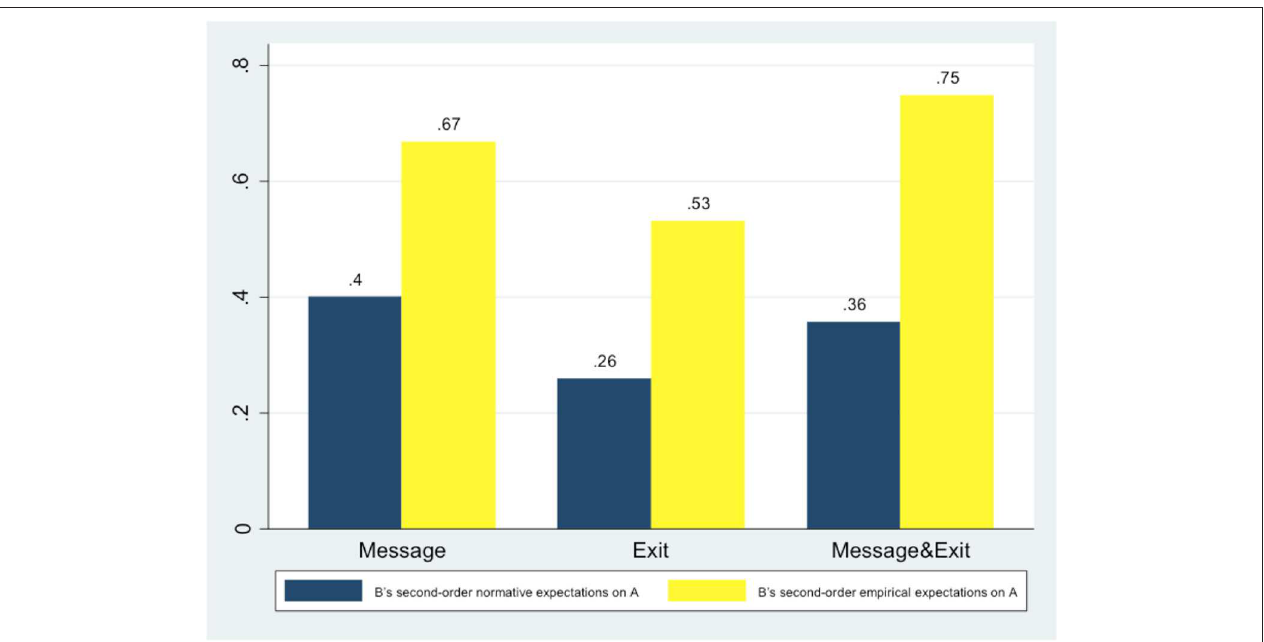
FIGURE 8 | Bs’ normative expectations on As and second-order empirical expectations on